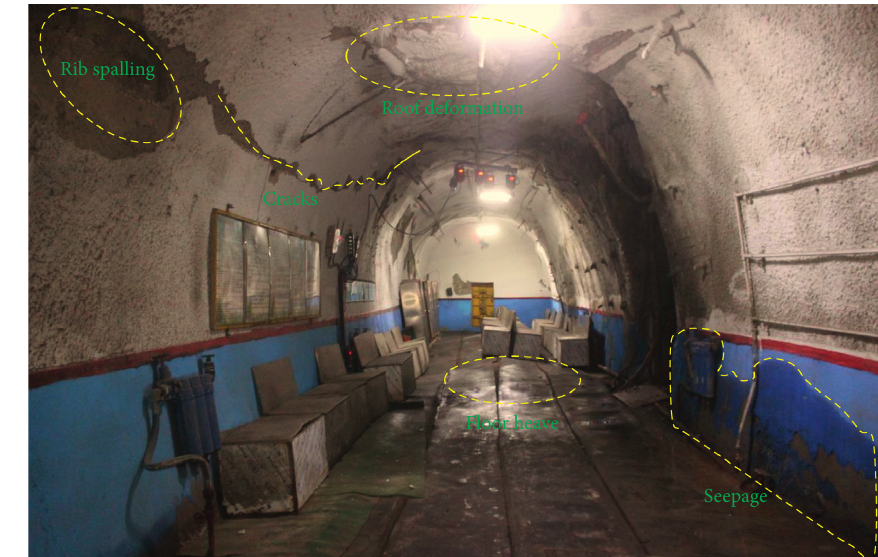
Figure 5: The instable conditions of the surrounding rock in the permanent refuge